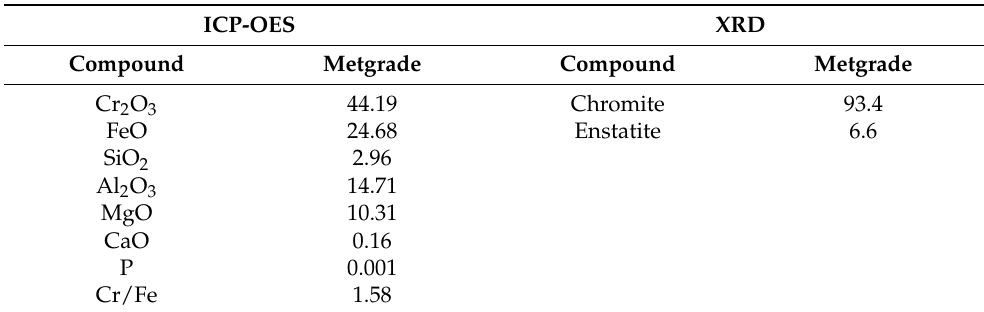
Table 1. Characterization of the case study chromite ore in terms of the chemical composition (ICP–OES, wt.%) [28], and mineralogical composition (XRD, wt.%).